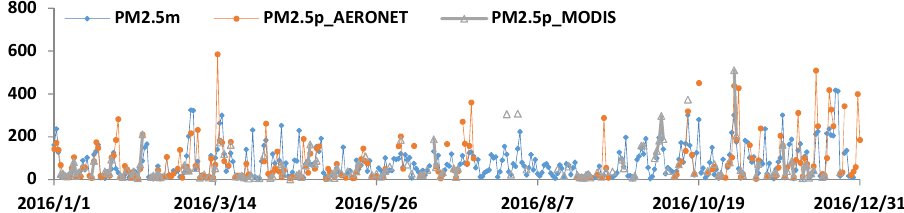
Figure 18. Time series distribution of SPSEMCA PM 2.5 retrieved result for DongSi PM 2.5 monitoring station based on AERONET and MODIS data, PM 2.5 m means PM 2.5 measured by the Beijing Air Quality Monitoring Network; PM 2.5 p_AERONET means the SPSEMCA predicted PM 2.5 based on the AERONET dataset; PM 2.5 p_MODIS means the SPSEMCA predicted PM 2.5 based on MODIS dataset.